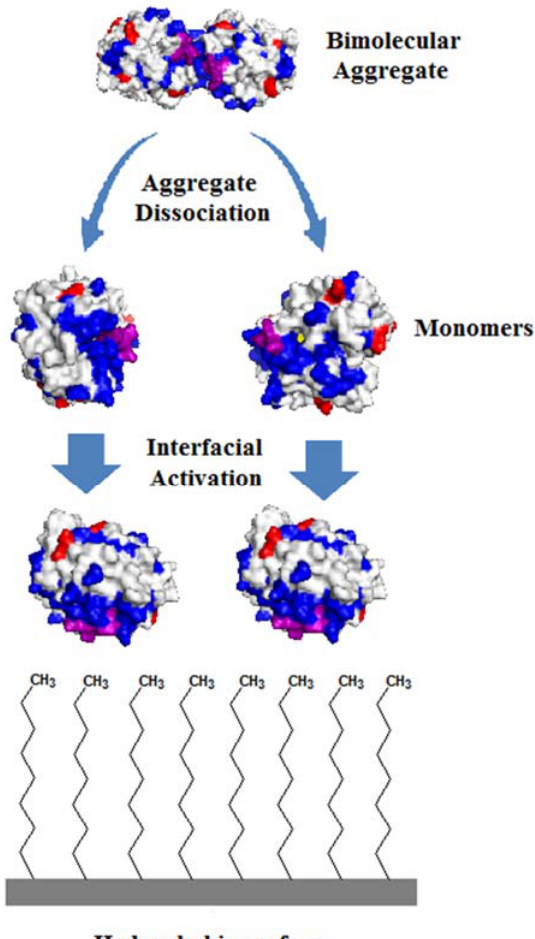
Figure 1. Schematic representation of dissociation of a TLL bimolecular aggregate in the presence of a hydrophobic surface (octyl-surface as an illustration). Bimolecular aggregate and monomer of TLL were obtained from Protein Databank (codes PDB 1DT3 and 1TIB, respectively). 3D-structures were constructed using PyMOL Molecular Graphics System, v. 1.7.4 (Schrödinger, LLC, Portland, OR, USA). Different colors represent the lid (purple), active site (yellow), lysine residues (red), and hydrophobic areas (blue).